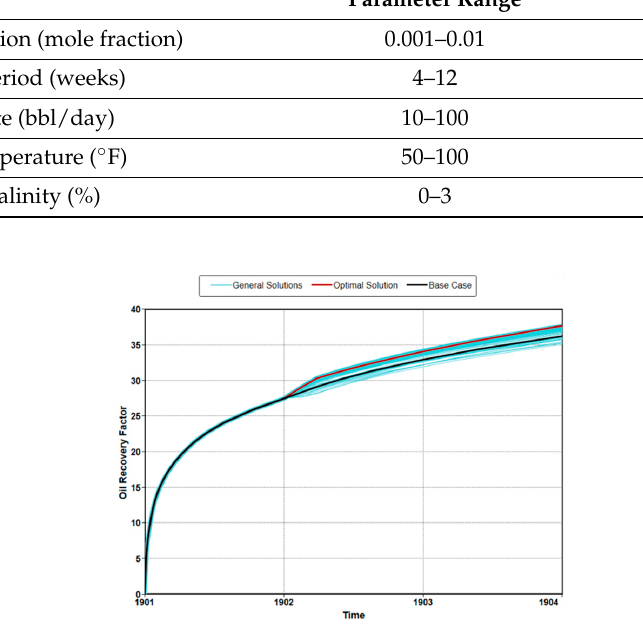
Figure 10. Oil recovery improvement by optimization.